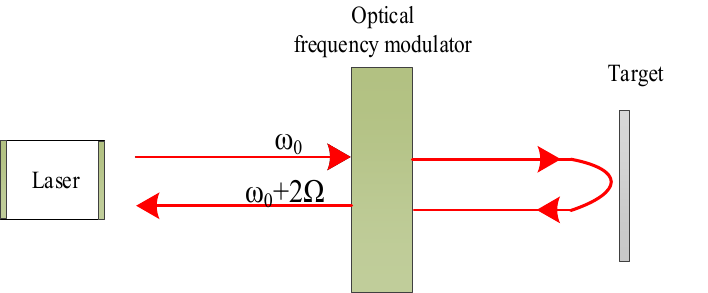
ω is the laser fre- 0